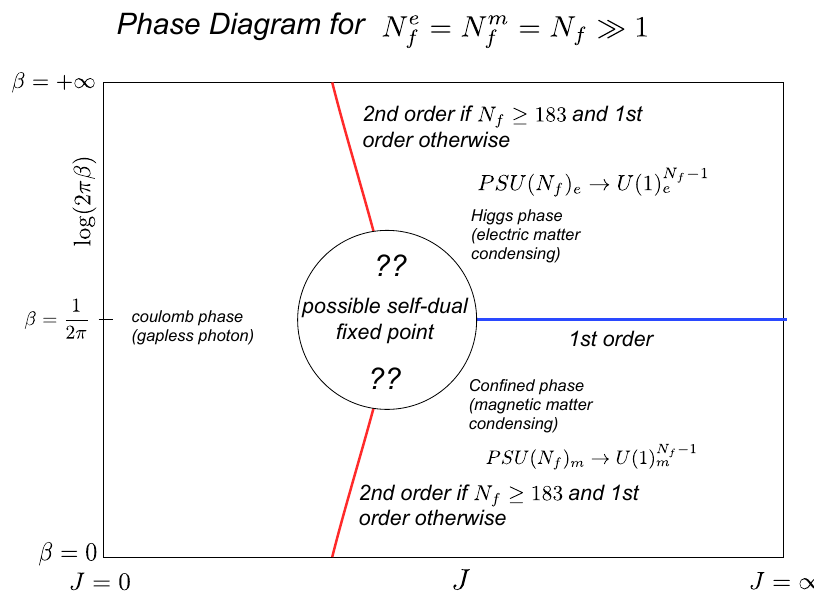
Figure 3 . The conjectured phase diagram for sufficiently large N e or β ∼ + ∞ can have a 2nd order phase transition if N f ≥ 183 , as discussed in section 2.5.